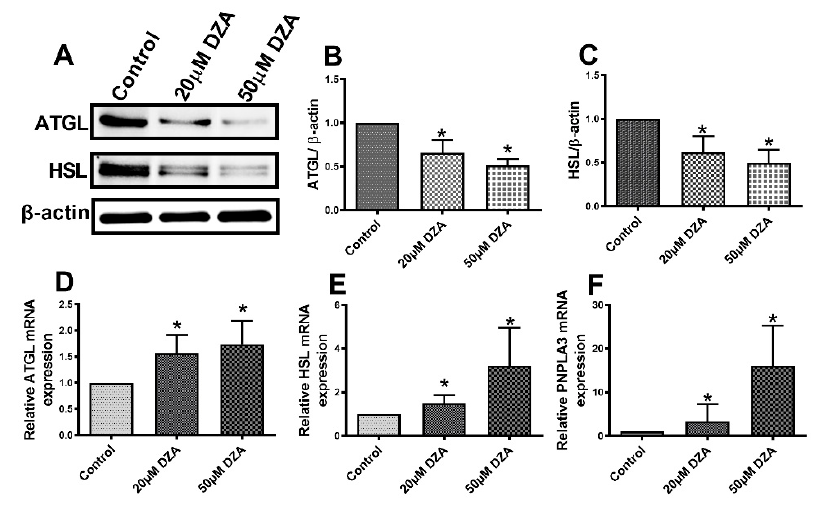
Figure 6. The expression of ATGL, HSL and PNPLA3 in control and DZA-treated hepatocytes. ( A ) Representative Western blot showing ATGL and HSL levels in control and DZA-treated cells. ( B ) Immunoblot analysis summarizing the protein band density of ATGL to β -actin, and ( C ) HSL to β -actin, n = 3 experiments. ( D ) Relative ATGL mRNA, ( E ) HSL mRNA and ( F ) PNPLA3 mRNA expression in control and DZA-treated hepatocytes ( n = 6–7 experiments). Asterisks indicate values for DZA-treated hepatocytes are statistically different from controls (* p ≤ 0.05 vs. Control).